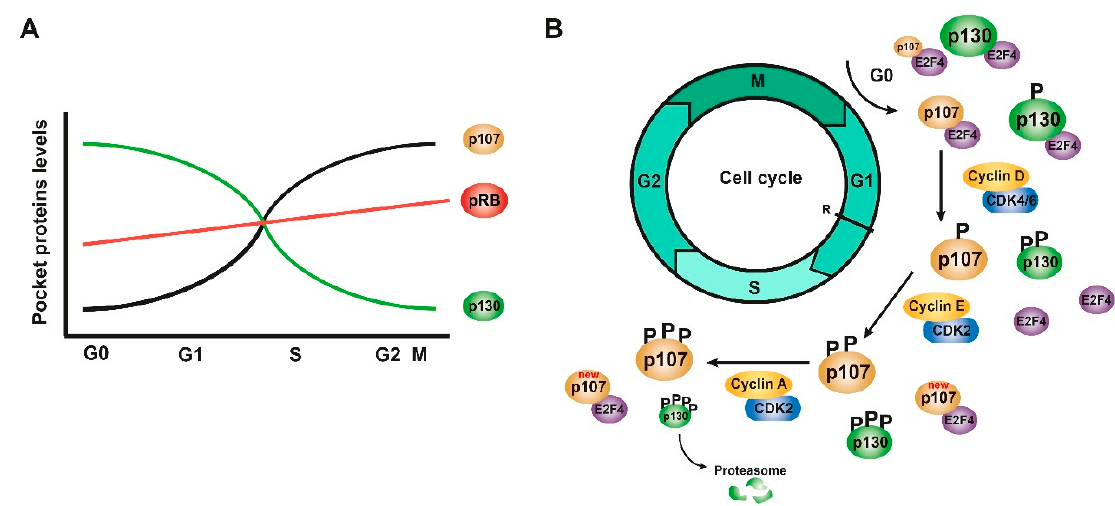
Figure 3. Pocket proteins collaborate in the control of the cell cycle. ( A ) Expression levels of the three proteins of the pocket family during the different phases of the cell cycle. ( B ) Scheme of the regulation of the phosphorylation and expression of p107 and p130 during G0, G1, and S phases. Figure adapted from [19–21,39].